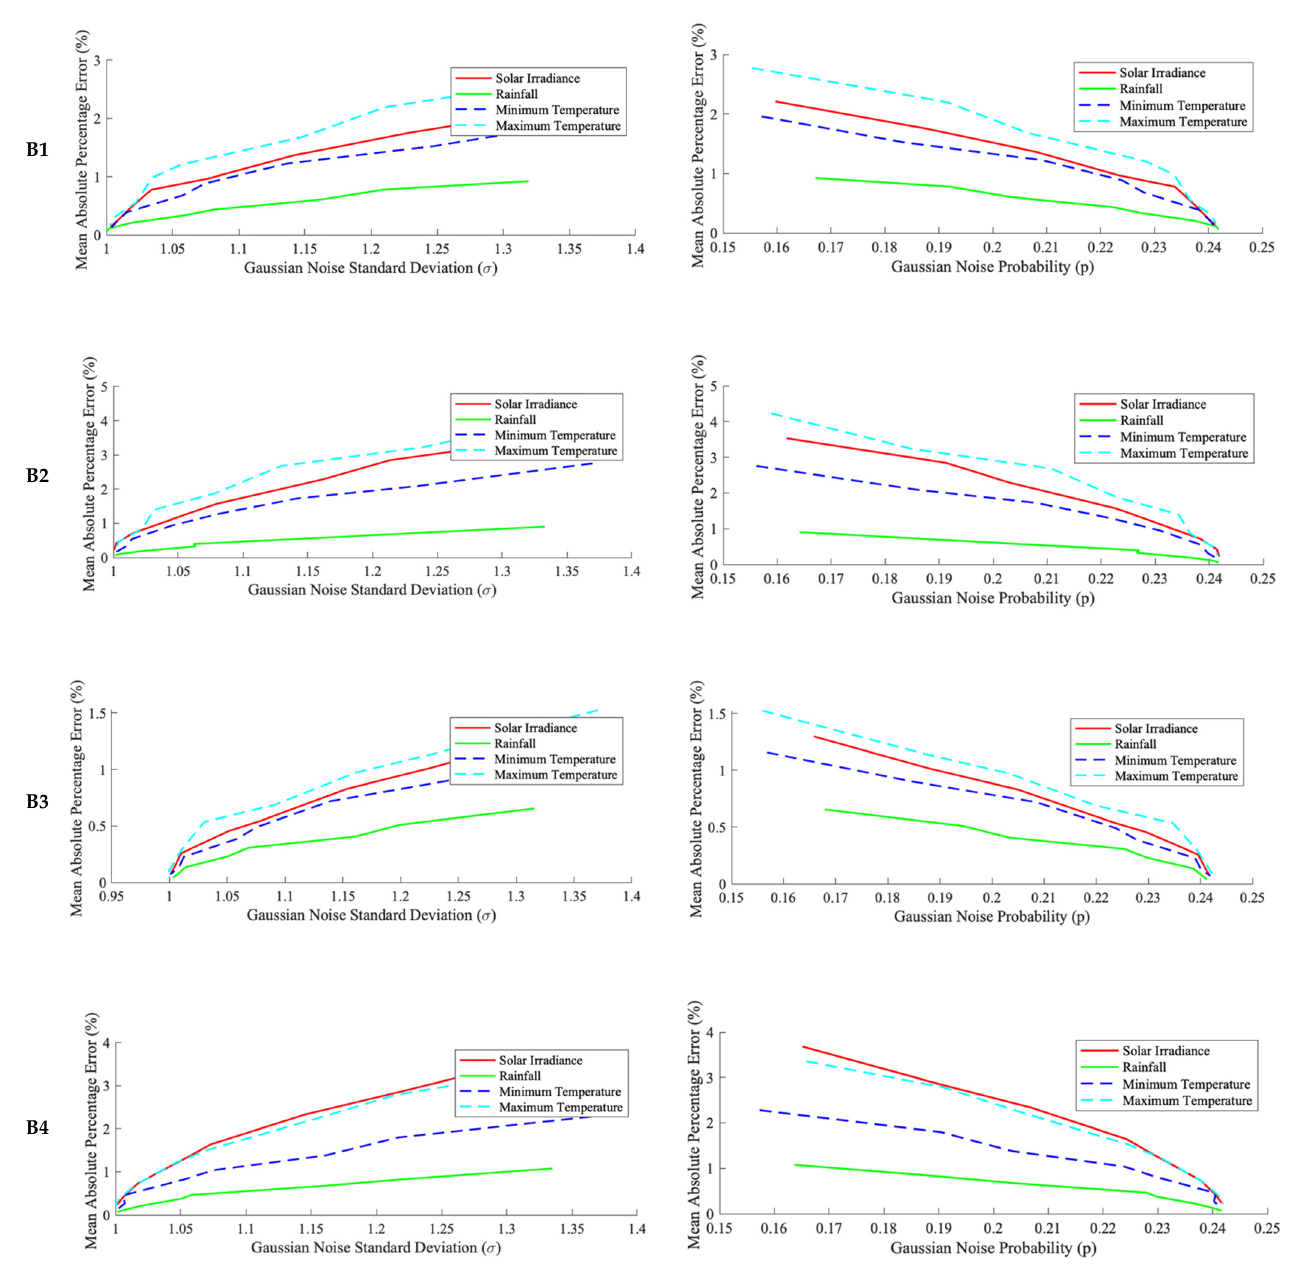
Figure 9. The NARX network sensitivity analysis for four input variables: solar irradiance, rainfall, and minimum temp and maximum temp.